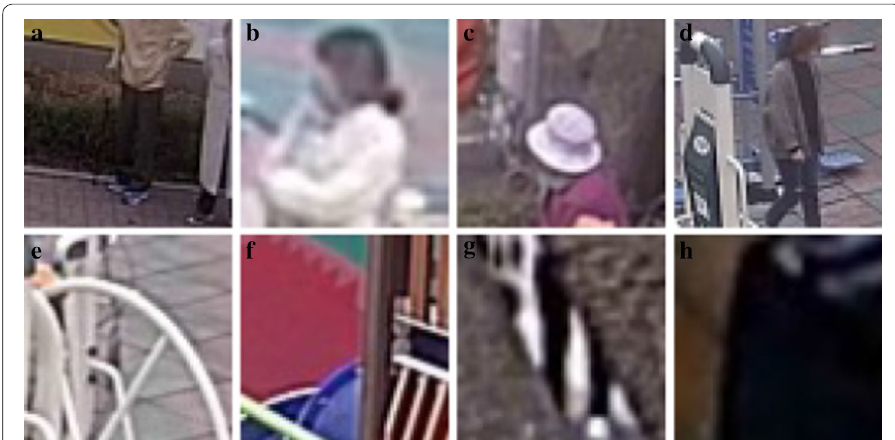
Fig. 6 Misclassified images for person class ( a – d ) and non‑person class ( e – h )